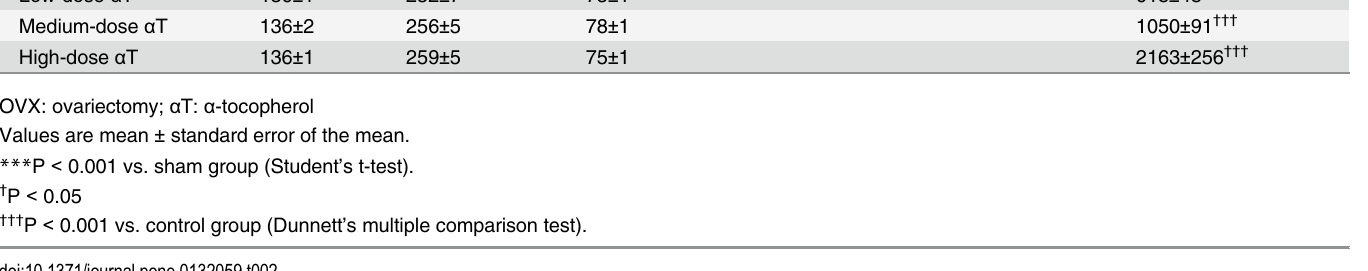
respectively, with statistical significance in comparison with the serum α T level in control rats